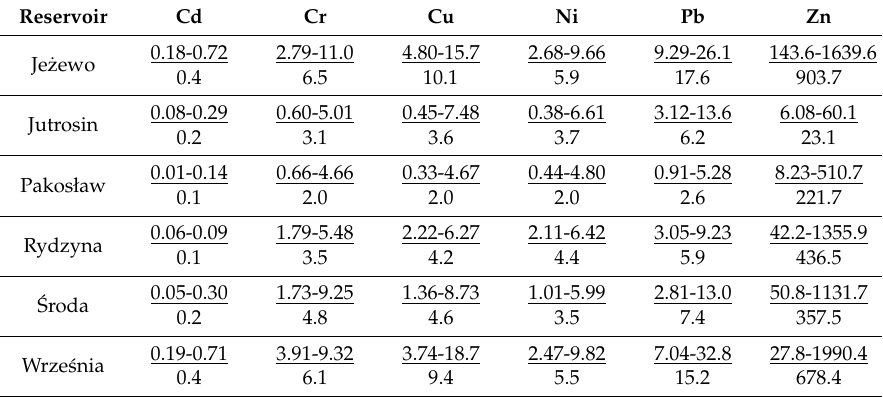
1 Upper values: minimum-maximum. Lower values: mean.